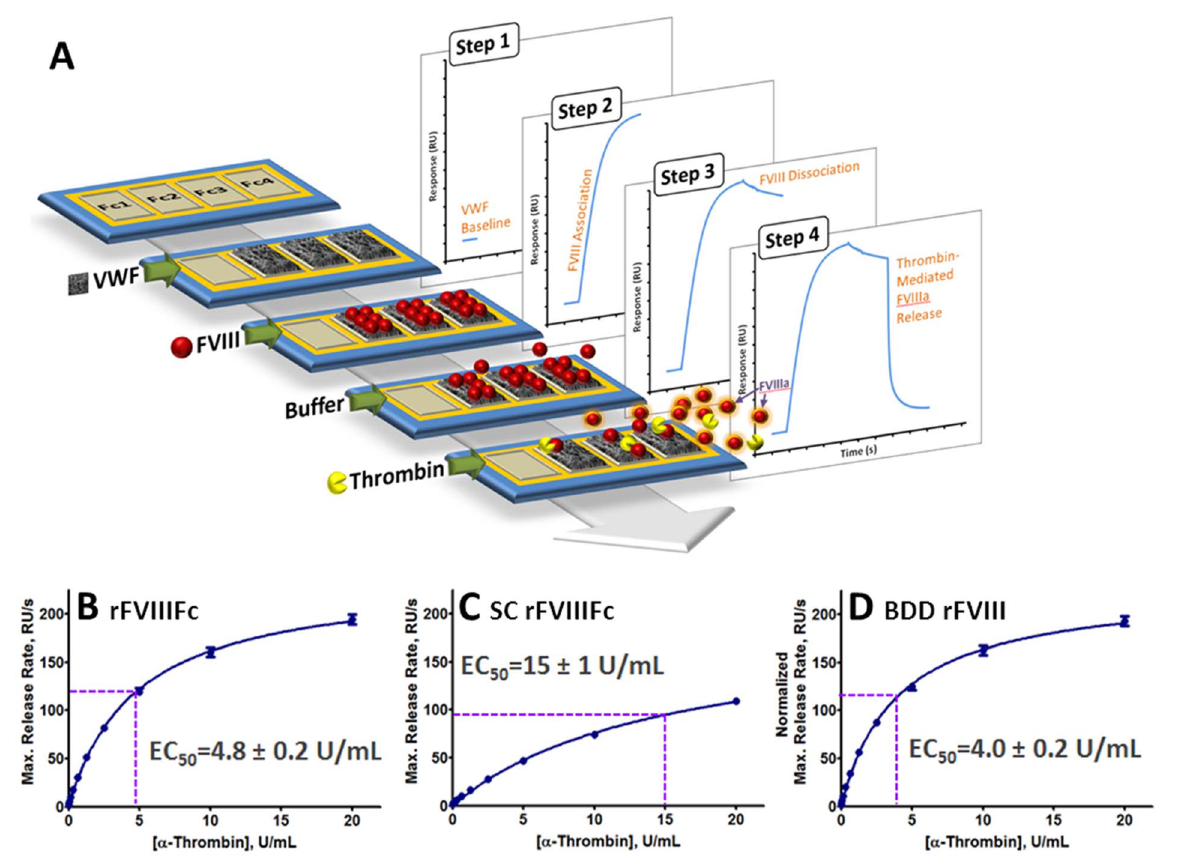
Figure 4. Thrombin-mediated release of activated FVIII variants from VWF. (A) Schematic of the optical biosensor method developed to evaluate the dependence of VWF release rates on thrombin concentration. A detailed description is provided in Materials and Methods . (B–D) Determination of thrombin concentrations corresponding to half-maximal release rates (EC 50 ) for (B) rFVIIIFc, (C) SC rFVIIIFc, and (D) BDD rFVIII. For BDD rFVIII, ordinate values were normalized on a molar basis to account for the molecular weight difference between rFVIIIFc and SC rFVIIIFc (220 kDa), and BDD rFVIII (170 kDa).